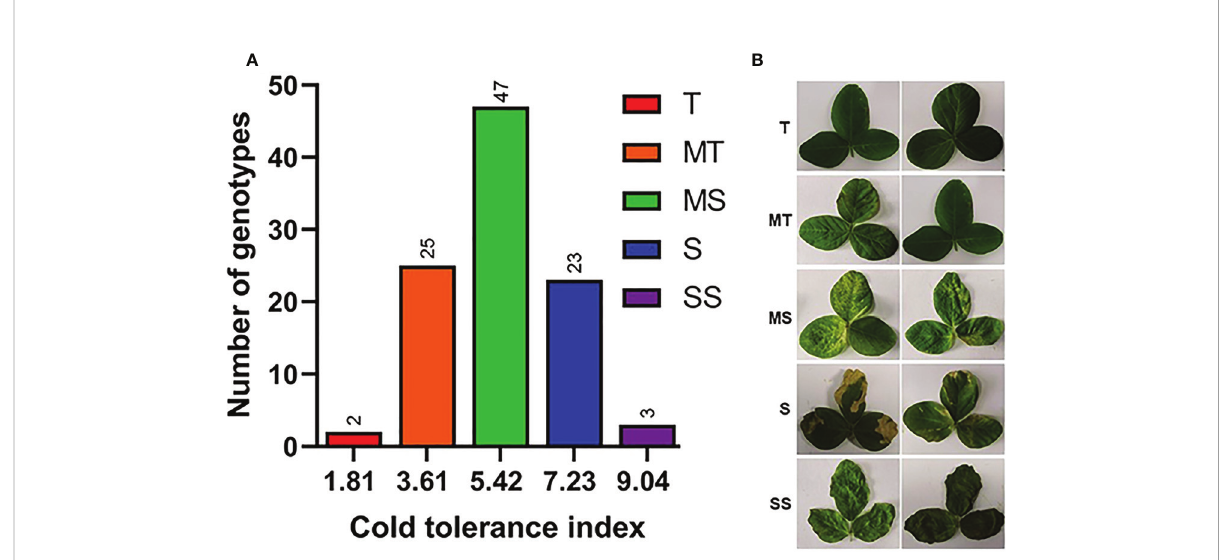
FIGURE 2 Cold tolerance selection index in diverse Soybean germplasm. (A) Cold tolerance indexes, (B) Phenotypic categorization, T, tolerant; MT, moderate tolerant; MS, Moderate sensitive; S, sensitive; SS, severely sensitive. Phenotype was analyzed after three days of